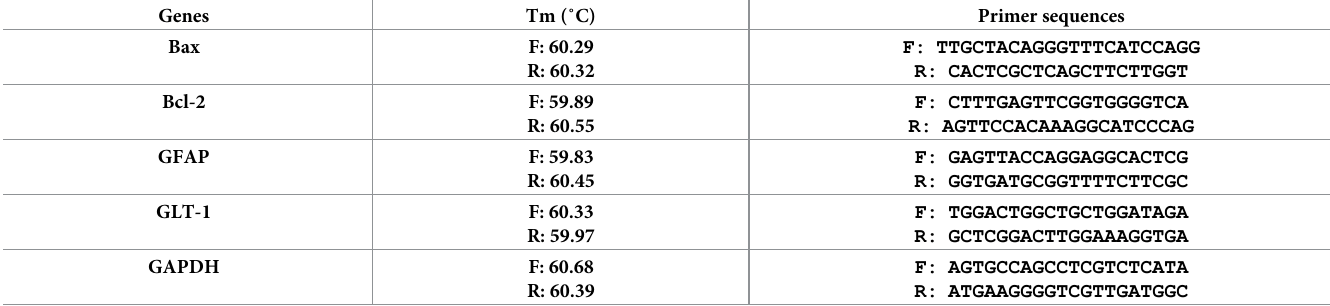
Table 2. List of primer sequences used for RT-PCR analysis. F: Forward primer, R: reverse primer, Tm: Melting temperature.